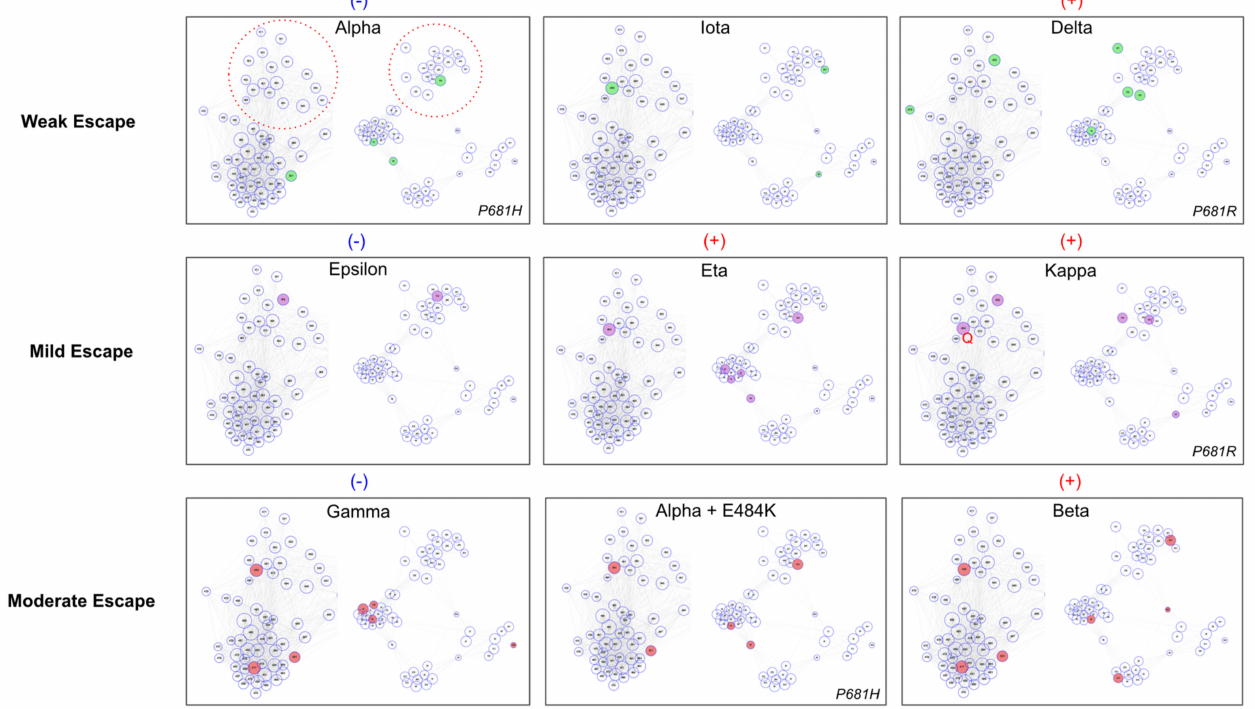
Figure 3. Nine Variants in RBD-ER-2 + NTD Epitope-Paratope Space. Variants with characterized in vitro escape via live virus neutralization [49] are projected in the antigenic space map from Figure 2 according to their relative reduction in PRNT50. The VOCs are divided into three groups for weak, mild, and moderate escape and further assigned blue ( − ) or red (+) to indicate relative escape magnitude within each horizontal grouping. The RBD ER-2C/D and NTD pan-supersite clusters are highlighted for reference as red dotted circles in the Alpha variant panel due to key escape residues occurring in these locations. The ER-2A biased group is cropped for clarity as none of the included variants feature mutations in this cluster. Variants with weak or mild escape tend to have a single ER-2C/D biased escape mutation (E484K or L452R) in combination with poor coverage of NTD clusters. Variants with mild escape tend to have relatively stronger NTD coverage (e.g., Eta vs. Iota) than variants with weak escape. VOCs with moderate escape feature mutations in two ER-2 clusters (e.g., E484K in ER-2C/D + K417N in ER-2B), and their relative escape strength is correlated with the degree of mutational coverage of the NTD clusters (i.e., Beta mutations span all four NTD clusters while Gamma’s NTD mutations occur within the same NTD cluster suggesting functional redundancy). Further, Gamma is the only variant that lacks a pan-supersite NTD mutation, potentially explaining its relatively weaker antibody evasion than